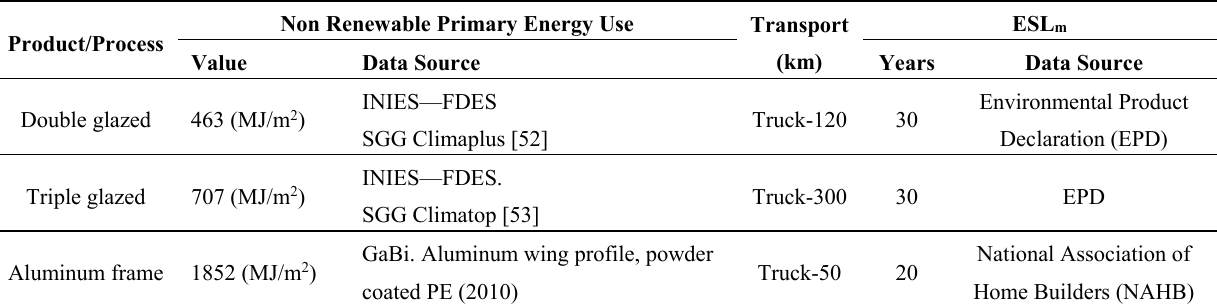
Table 5. Non Renewable Primary Energy (NRPE), Transport characteristics, and Estimated Service Life of the materials ( ESL m ) for products and processes included in the